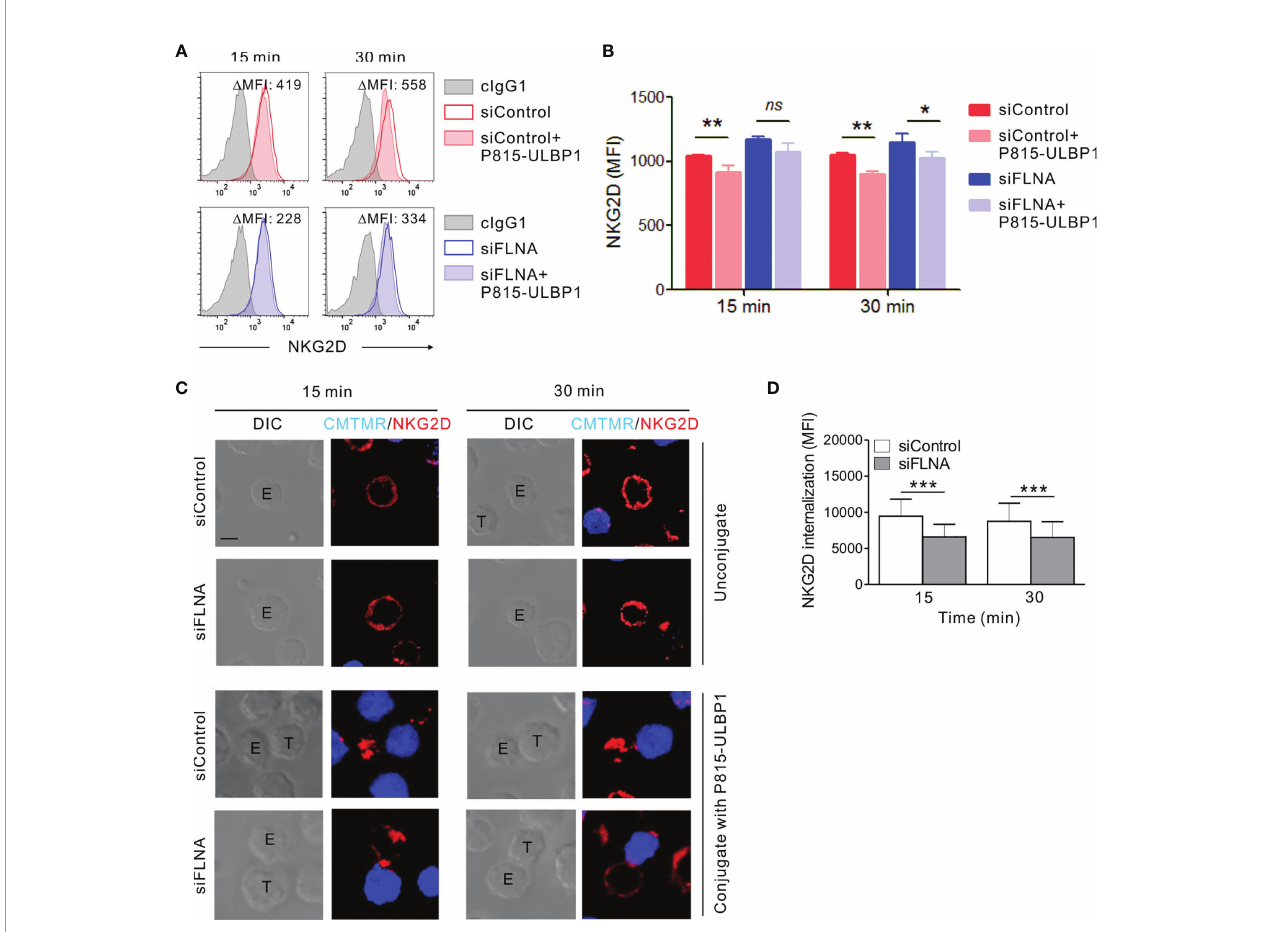
FIGURE 8 | Loss of FLNa attenuates ligand-induced NKG2D internalization. (A, B) Rested NKL cells nucleofected with control siRNA or FLNa-speci fi c RNA were incubated with Far red-labeled P815-ULBP1 cells for the indicated times. The surface levels of NKG2D on NKL cells were measured by fl ow cytometry after staining with an anti-NKG2D Ab. Representative FACS plots (A) and statistical graph (B) showing the mean fl uorescent intensity (MFI) of surface NKG2D after co-culture with P815-ULBP1 cells relative to NKG2D MFI without co-culture ( D MFI). (C) Rested NKL cells nucleofected with control or FLNa-speci fi c siRNAs were incubated with Cell tracker orange CMTMR-labeled P815-ULBP1 cells (blue) for the indicated times. Conjugates were subject to fi x and permeabilization and then stained with an anti-NKG2D Ab (red). Conjugates were analyzed using confocal microscopy to assess the localization of NKG2D in the NKL cells. Representative confocal images of NKL cells ( top ) or conjugates between NKL cells and P815-ULBP1 cells ( bottom ) are presented. (D) Quanti fi cation of NKG2D internalization in NKL cells conjugated with P815-ULBP1 cells. Error bars represent the SD; * P < 0.05, ** P < 0.01, *** P < 0.001. Scale bar, 5 m m. Results are representative of three independent experiments. ns, not signi fi